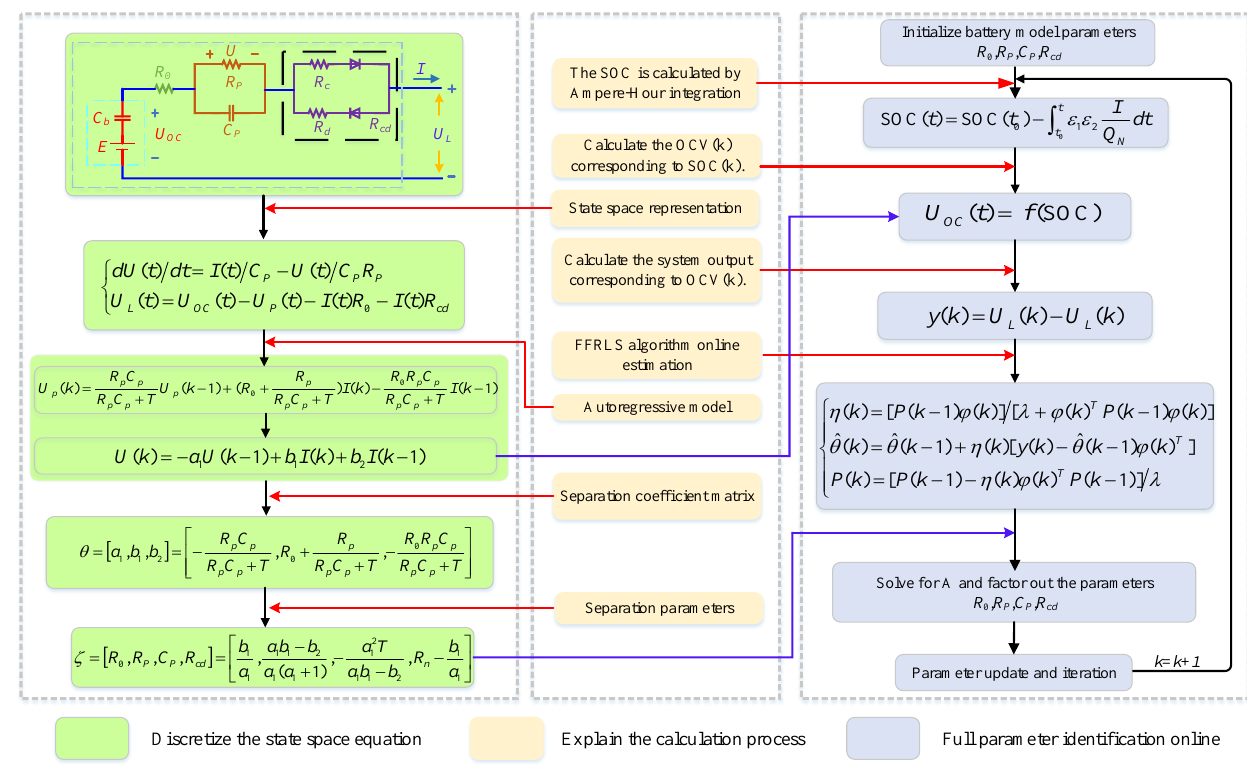
Figure 2. Diagram of the general structure of online parameter identification based on FFRLS.